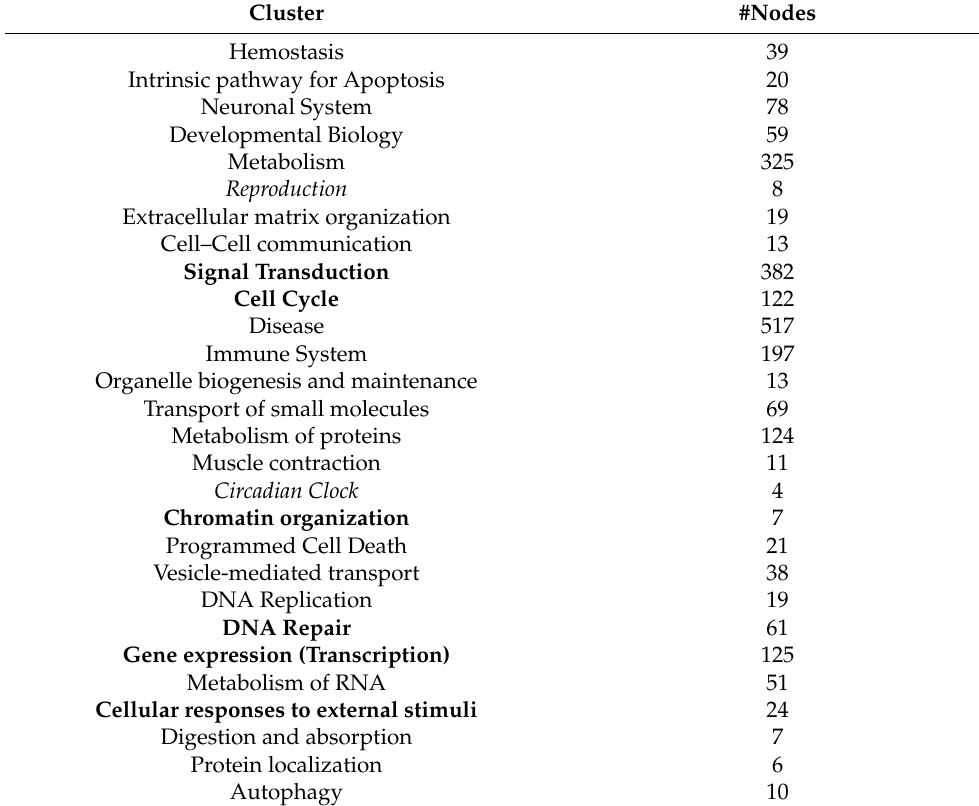
Table 3. The 28 connected components of the complete network of human pathway hierarchies. HCC-USP15 pathways were significantly enriched in eight connected components, so-called clusters. We denoted six of the enriched clusters (in bold) as relevant to tumor research, highlighted in boldface. Two clusters, “Reproduction” and “Circadian Clock” (in italic), were significantly enriched but not denoted as cancer-related. #: numbers. Cluster #Nodes Hemostasis 39 Intrinsic pathway for Apoptosis 20 Neuronal System 78 Developmental Biology 59 Metabolism 325 Reproduction 8 Extracellular matrix organization 19 Cell–Cell communication 13 Signal Transduction 382 Cell Cycle 122 Disease Immune System 197 Organelle biogenesis and maintenance Transport of small